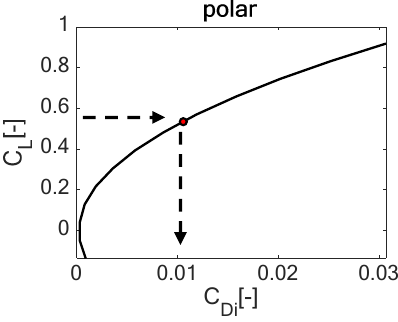
Figure 14. Induced drag computation starting from polar curve for a cruise Mach of 0.83; for a given value of C L , the associated C Di value is obtained.